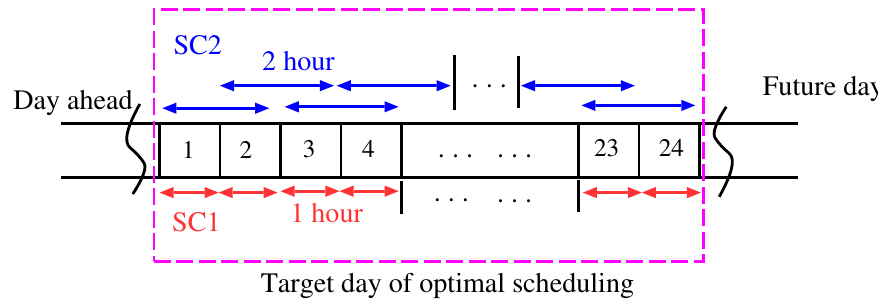
Figure 6. Scheduling (SC) method for optimal scheduling.